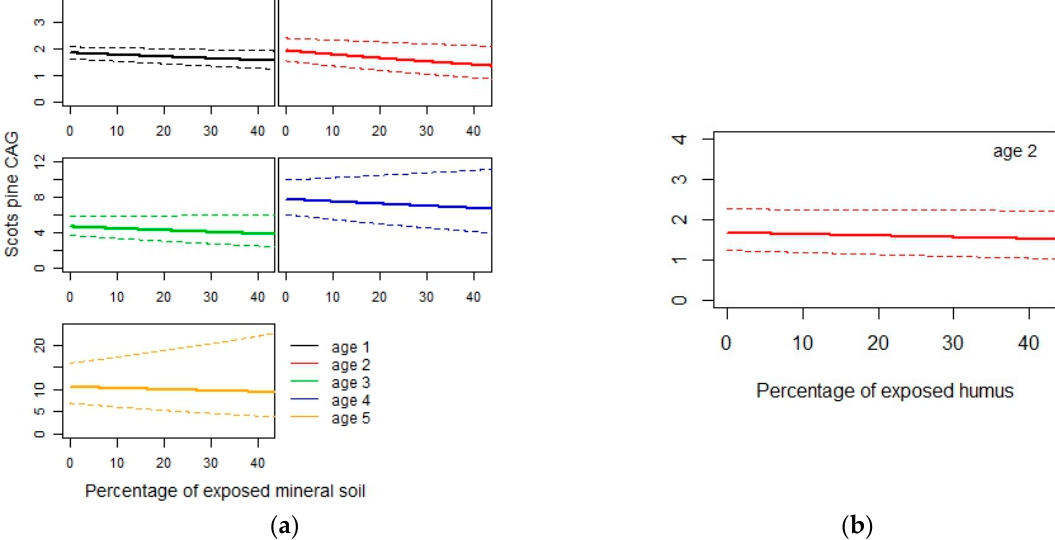
Figure 2. Predicted models for current annual growth of Scots pine at different age classes with ( a ) increasing proportion of exposed mineral soil, and ( b ) increasing proportion of exposed humus, here presented for age = 2. The dotted lines indicate the 95% confidence interval. The prediction line for ( a )